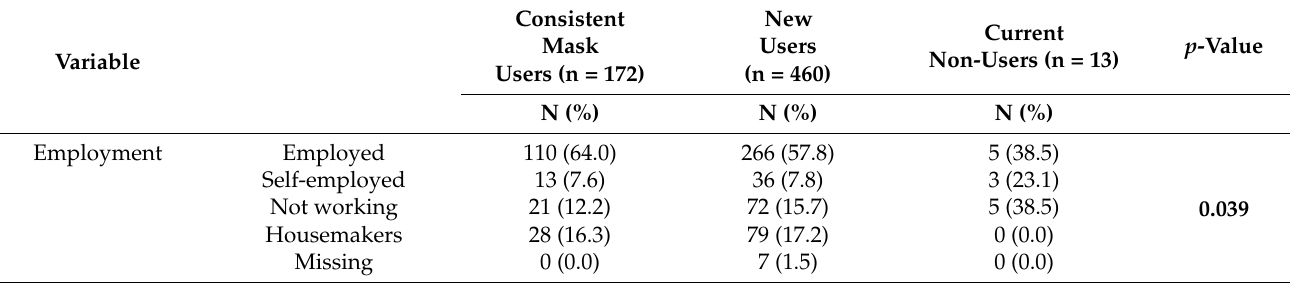
Table 5. Distribution of work-related characteristics by mask use behavior (n =